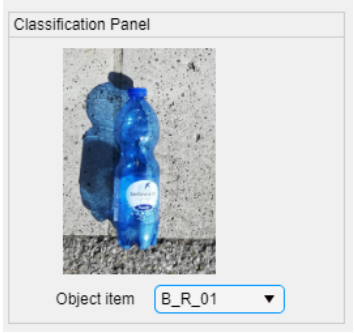
Figure 14. Classification